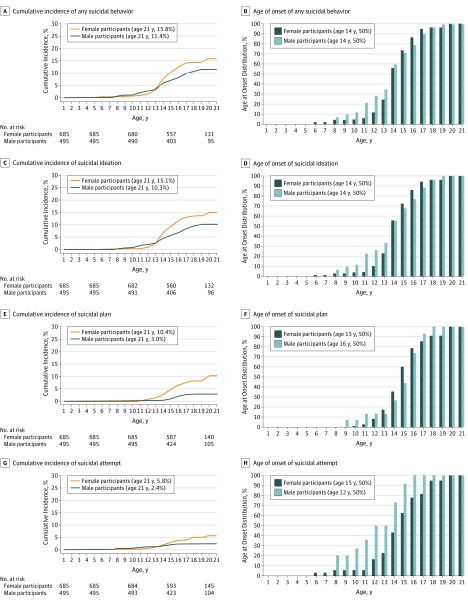
Age-Specific Cumulative Incidence and Age at Onset Distribution for Suicidal Behavior by Sex for 1180 ParticipantsEstimated age-specific cumulative incidence rates from survival analyses and age-at-onset distributions are shown for any suicidal behavior (A and B, respectively), suicidal ideation (C and D, respectively), suicide plan (E and F, respectively), and suicide attempt (G and H, respectively) until age 21 years, stratified by sex and age. Any suicidal behavior comprises any suicidal ideation, plan, and attempt. The median age at onset was determined by the lowest age where the estimated cumulative incidence exceeded one-half of the estimated cumulative incidence at age 21 years. Reported number at risk tables are based on the unweighted Kaplan-Meier estimation.